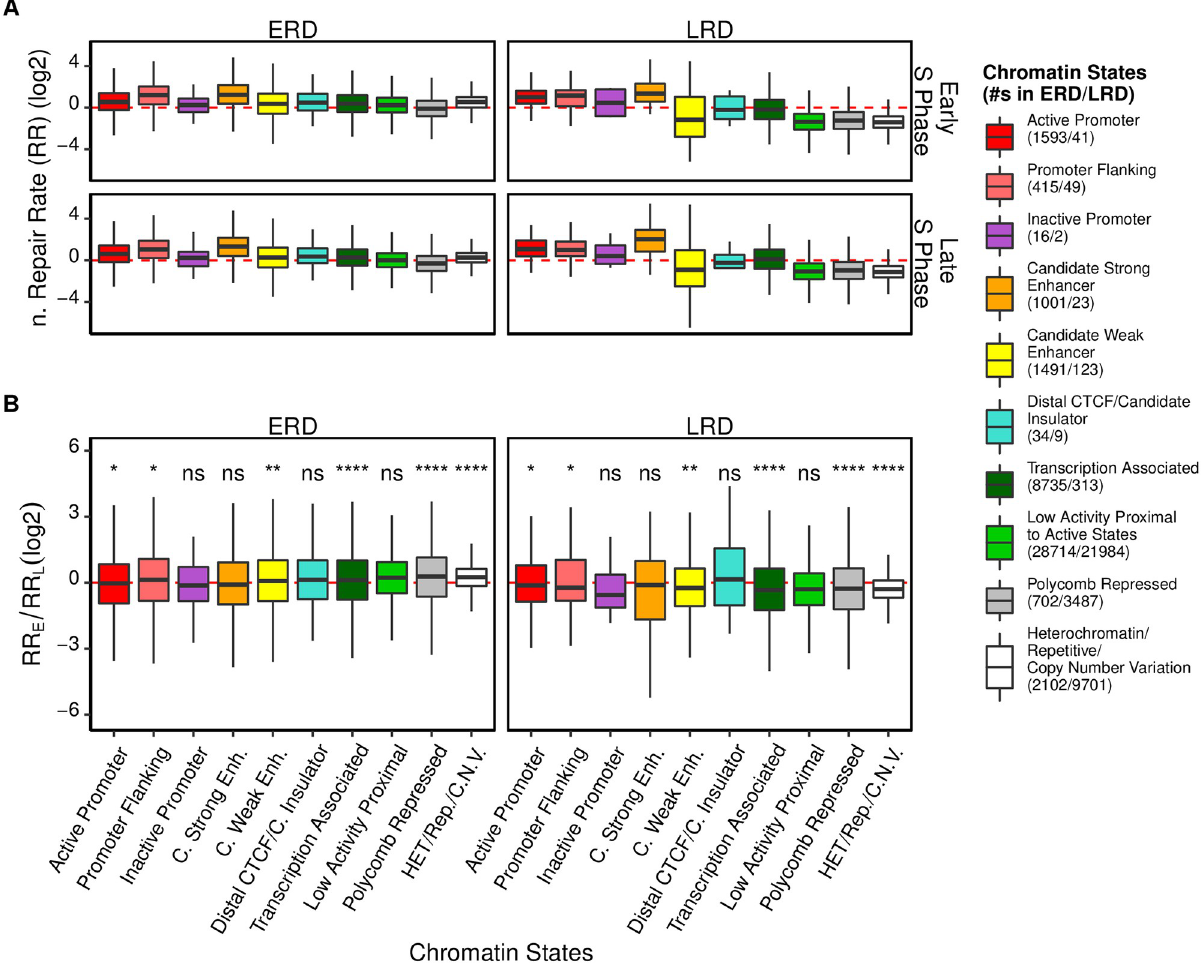
Fig 3. The effect of chromatin states along with replication timing on repair. (A) Boxplot of normalized repair rates [log2(XR-seq real/simulation / Damage-seq real/simulation )] of CPDs at 12 minutes after UV at early and late S phases for each chromatin state. (B) Relative difference of early S phase and late S phase repair rates [log2(RR Early S Phase /RR Late S Phase )] for each chromatin state. The wilcoxon test was used to assess the significance of differences between [log2(RR Early S Phase /RR Late S Phase )] and 0. Replicate A and B are combined.